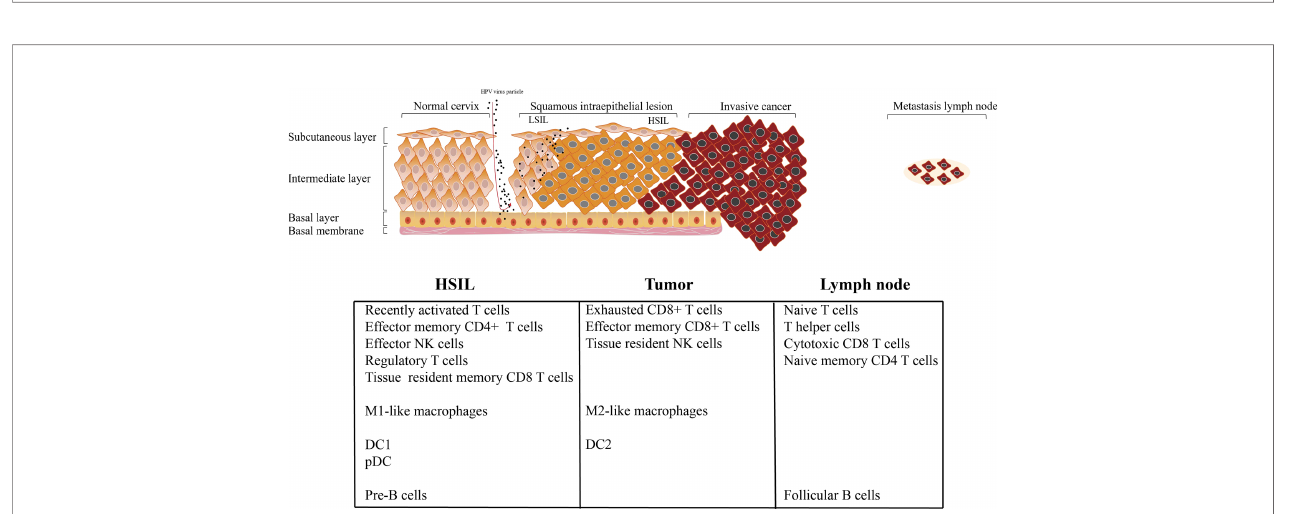
FIGURE 7 | The dense network and multiple cellular connections. Circos plot showing the interactions between ligands and receptors across cell types in HSIL(left), tumor (middle), and lymph node (right) (A) . Bubble diagram showing MHC moleculars, immune receptors, chemokine and immune checkpint among different immune cells in HSIL (B) , tumor (C) and lymph node (D) . The association of different signaling pathways among different immune cells in HSIL, tumor and lymph node group (E)